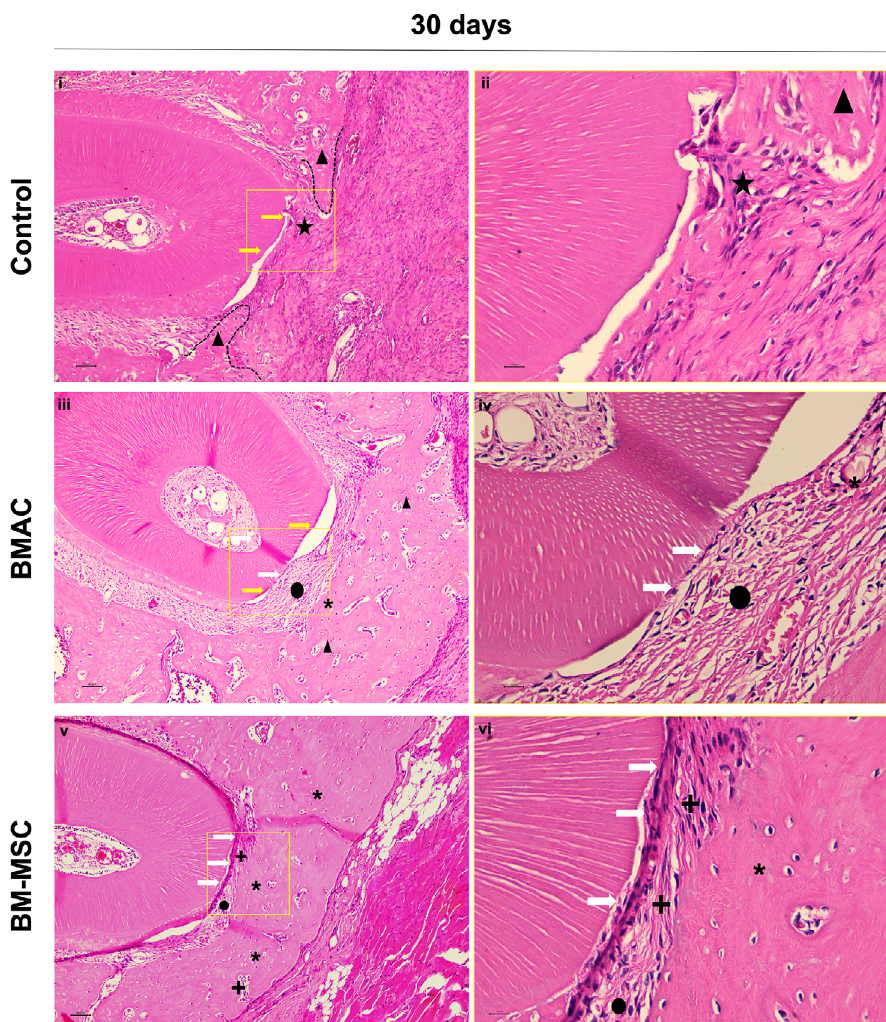
Figure 4- Histological view of the center of the periodontal fenestration defect within postoperative 30 days of spontaneous healing (i, ii),and BMAC (iii, iv) and BM-MSCs (v, vi) treatments (H.E., original magnification 10× and 40×). Yellow rectangles represent the area of magnification. Yellow arrows represent the denuded distal root of the first molar in the center of the defect. Dashed lines delineate the new bone formed into the defect from the edges to the center of the no-closed defects in the Control group. Stars represent rich connective tissue in the center of the no-closed defects in the Control group. Triangles indicate new immature bone and asterisks indicate new regular mature bone. Circles represent new periodontal ligament with non-inserted new fibers disposed of at parallel. A complete periodontal regeneration is shown in the BM-MSCs group (v, vi). White arrows indicate the thin layer of new cellular cementum-like tissue. A plus sign represents the new periodontal ligament with inserted fibers, obliquely disposed in the new